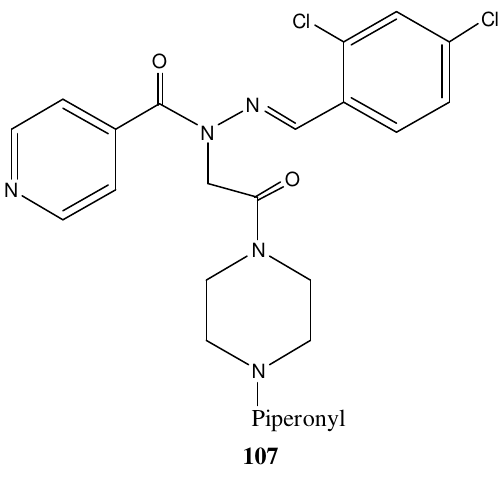
FIGURE 8. Structure of compound 107 .